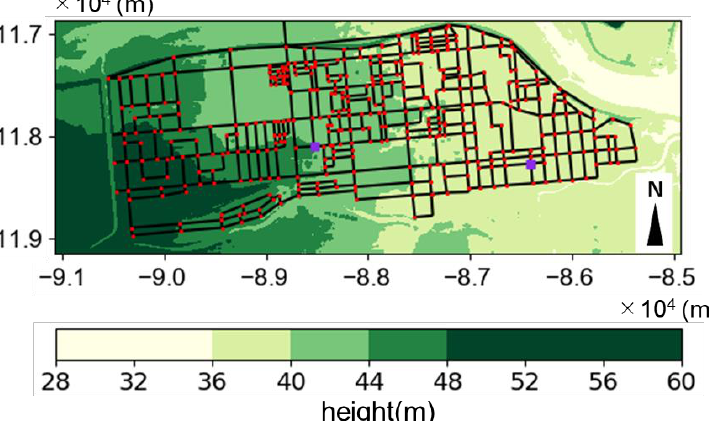
Figure 2. Load map and elevation contour map of the study site in Obihiro city, Hokkaido, Japan . Red points show the departure points of evacuees. Purple points show the two destination points (i.e., flood shelters). The x- and y-axes indicate the axis in the Japan Plane Rectangular Coordinate System Xll.